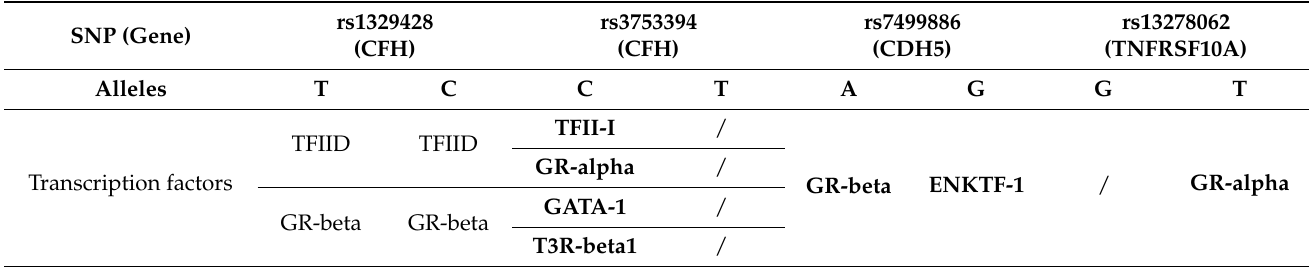
Table 6. Transcription factor binding sites predictions for the studied non-coding polymorphisms using PROMO (ALLGEN) software. Changes in transcriptional factor binding sites are indicated in bold